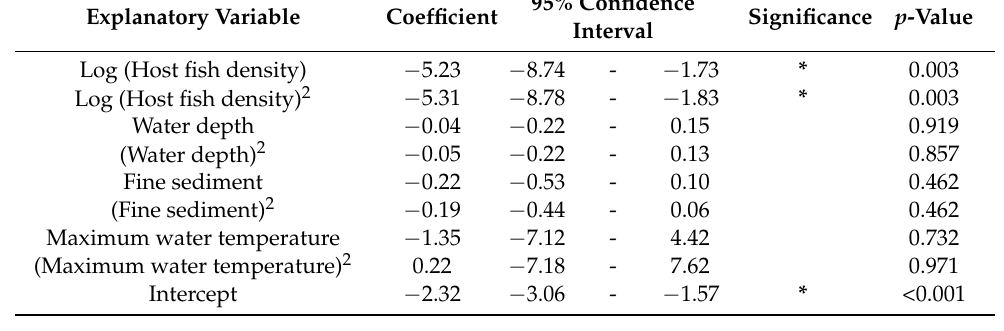
Table 1. Results of the averaged models examining the relative effects of factors affecting the recruitment success of M. laevis . Significant results according to the significance test ( α = 0.05) are indicated with an asterisk.